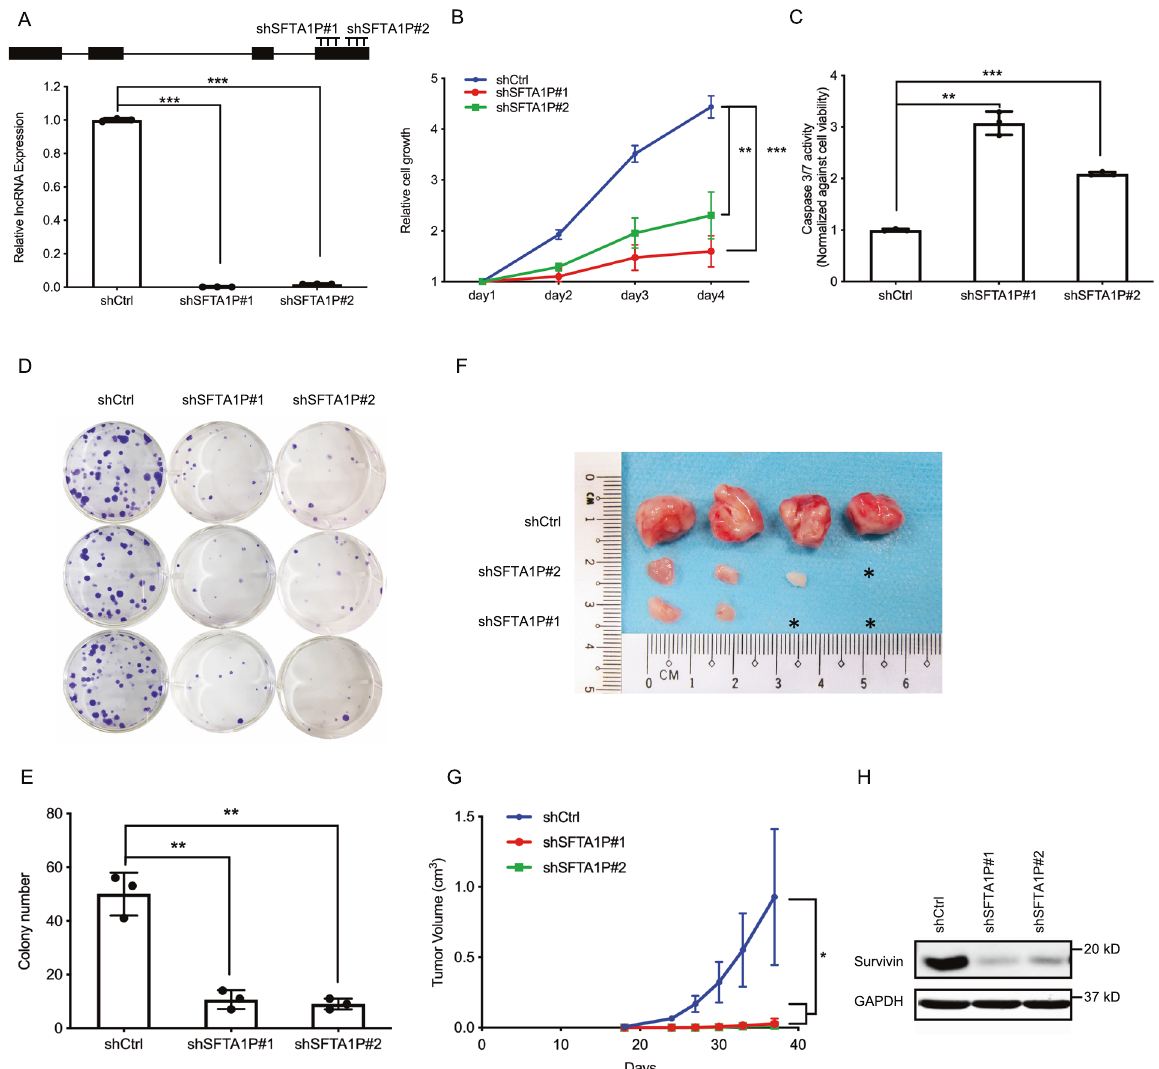
Fig. 2 Loss of SFTA1P inhibits tumor growth in vitro and in vivo. A Schematic annotations of SFTA1P and two shRNAs against the 4th exon of SFTA1P (top panel). The knockdown ef fi ciencies were evaluated by RT-qPCR in H1299 cells (bottom panel). B The cell growth curve was measured by cell viability assay following shRNA-mediated silencing of SFTA1P. The relative viabilities of each treatment on day 4 were subjected to statistical analysis. Mean ± SD, n = 3 (biological replicates). C Caspase 3/7 assay measures the caspases activity upon knockdown of SFTA1P in H1299 cells. The relative caspase 3/7 activities were obtained by normalizing the raw readouts against the corresponding cell viabilities estimated by CellTiter Glo. Mean ± SD, n = 3 (biological replicates). D – E Colony formation assay ( D ) and the corresponding quanti fi cation ( E ) in H1299 cell upon shRNA transduction. Mean ± SD, n = 3 (biological replicates). F – G A representative image ( F ) and quantitative analysis ( G ) of the volumes of tumors formed after subcutaneously transplanting 4 × 10 5 H1299 cells transduced with shRNAs. Mean ± SD, n = 3 (biological replicates). H Western blot analysis of survivin expression upon the knockdown of SFTA1P. Statistical signi fi cance was determined using Student ’ s t -test, * p < 0.05, ** p < 0.01, *** p < (Fig. 4B, C). In contrast, inhibiting proteasome-mediated protein degradation using MG132 increased TAZ protein levels (Fig. 4B, C). Importantly, MG132 treatment led to an accumulation of TAZ only in the shCtrl-transduced cells but not in the cells transduced with shSFTA1P (Fig. 4B, C), suggesting that SFTA1P might regulate TAZ expression upstream of its degradation. Altogether, the results indicate that the SFTA1P-driven TAZ regulation is likely at the level of protein translation. This hypothesis is also supported by the fact that SFTA1P primarily localizes to the cytoplasm (Fig. 1I), its likely site of activity, and the compartment where protein translation also occurs. To further delineate the underlying mechanism of TAZ